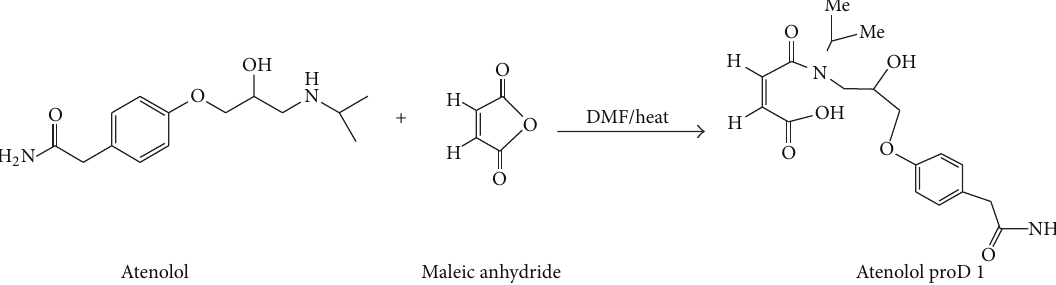
Figure 1: Synthetic scheme for the preparation of atenolol ProD 1 from its parent drug, atenolol and maleic anhydride.